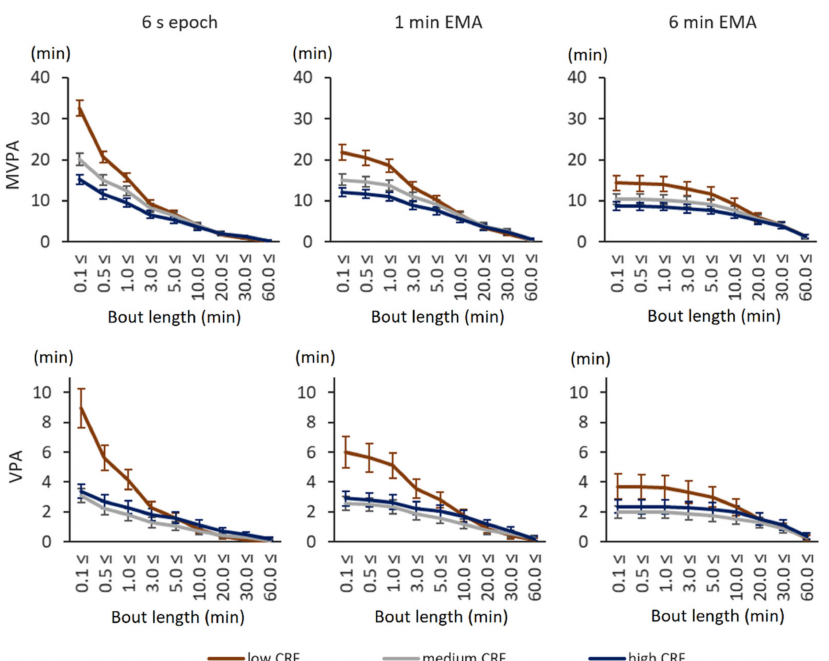
Figure 2. Daily MVPA and VPA time accumulation with relative fitness-based intensity thresholds. The x -axis shows the minimum accepted bout length, and the y -axis shows the accumulated time in minutes. The error bars denote 95% confidence intervals. The upper graphs show the accumulated MVPA time (over 40% of VO 2 R), and the lower graphs show the VPA time (over 60% of VO 2 R). The left-most graphs show the accumulated time from 6 s epoch, the middle graphs show that from 1 min EMA, and the right-most graphs show that from 6 min EMA.